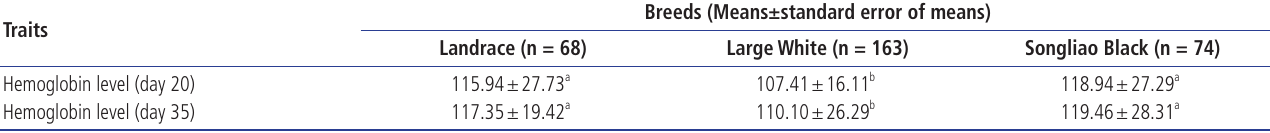
Genotypes (Means±standard error of means)